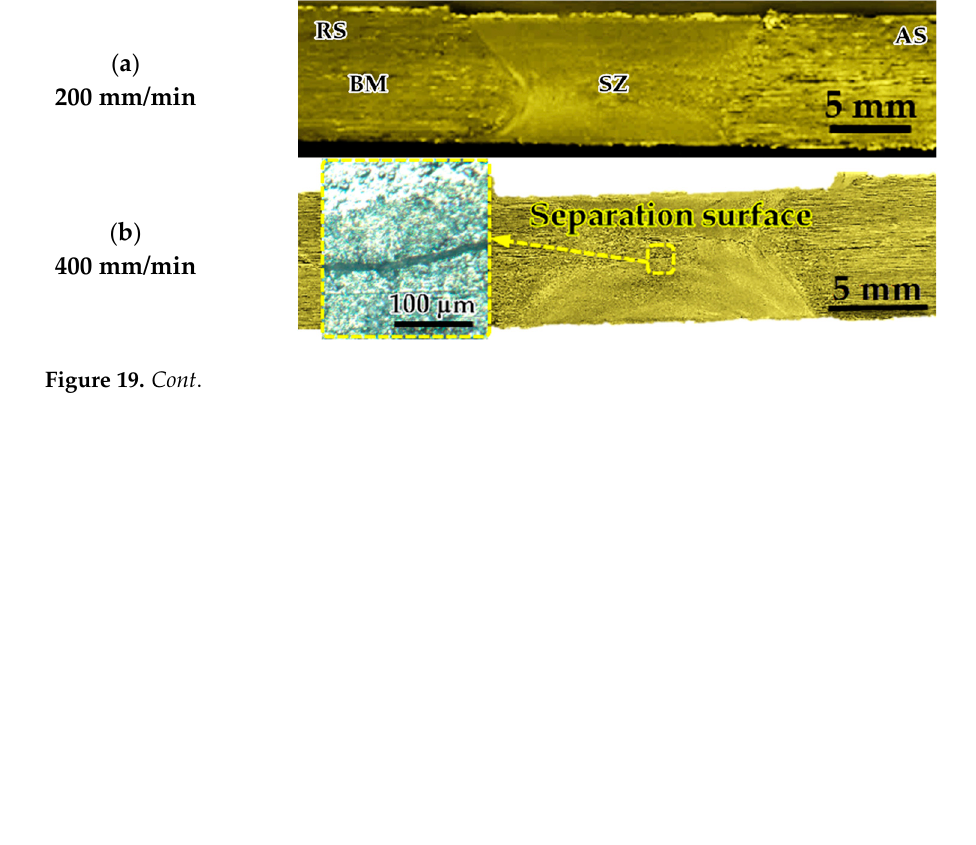
Figure 18. Macrographs of transverse cross-sections of lap joints produced at 600 rpm rotation speed and different travel speeds of ( a ) 200, ( b ) 400, ( c ) 600, ( d ) 800, and ( e ) 1000 using BT with Sq pin.